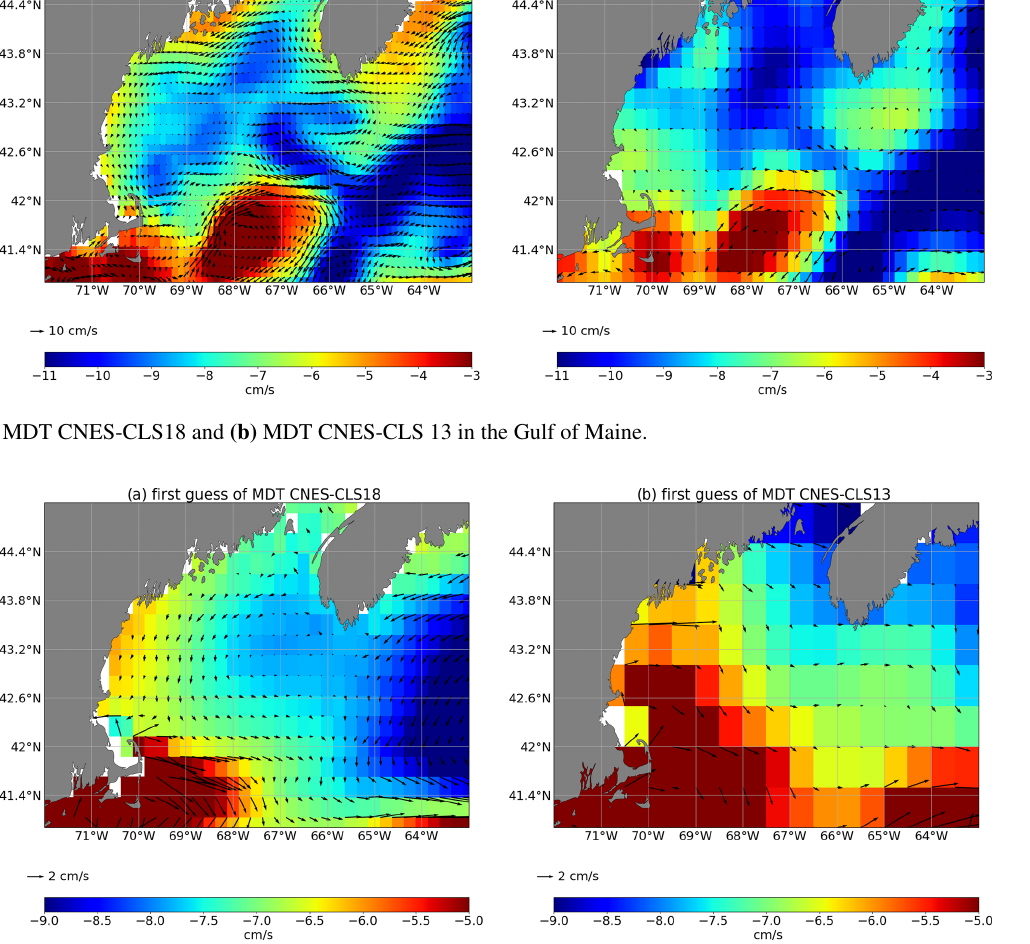
Figure 11. First guess of the MDTs (a) CNES-CLS18 and (b) CNES-CLS13 in the Gulf of Maine.